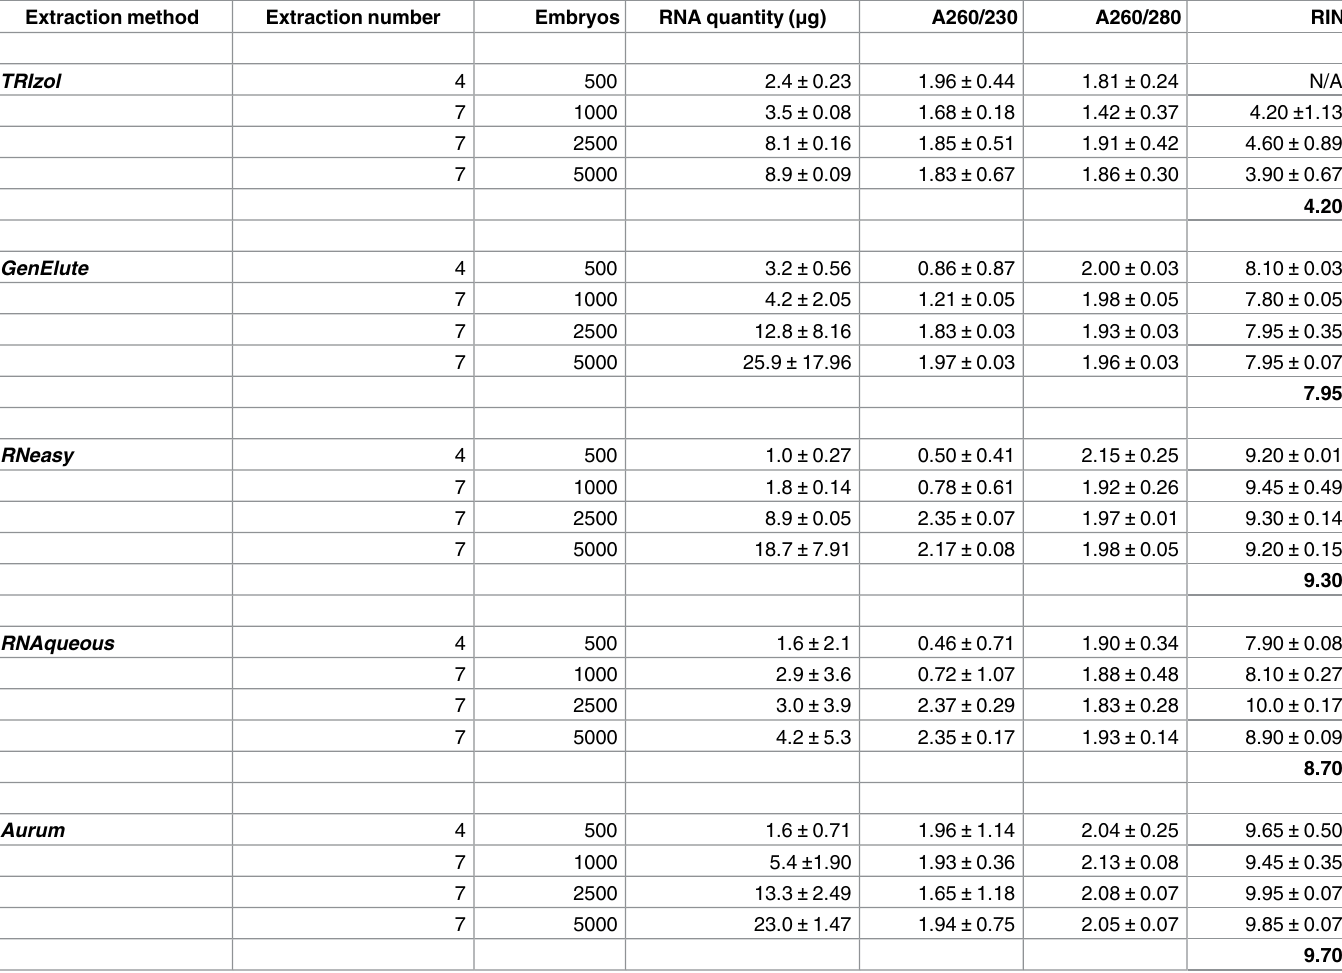
Table 1. Extraction number, total RNA quantity ( μ g), purity (A260/280 and A260/230)and integrity (RIN values) from different number of P . lividus embryos using five different extraction methods: TRIzol, GenElute ™ Mammalian Total RNA Miniprep Kit (Sigma-Aldrich), RNAqueous ® Micro Kit (Ambion from Life Technologies), RNeasy ® Micro Kit (Qiagen) and Aurum ™ Total RNA Mini Kit (Biorad). Valuesrepresent mean ± SD. Values in bold in the RIN column are the averagevalues among the RIN values obtained at the different numberof P . lividus embryos. N/A indicates samplesin which no val- ues are